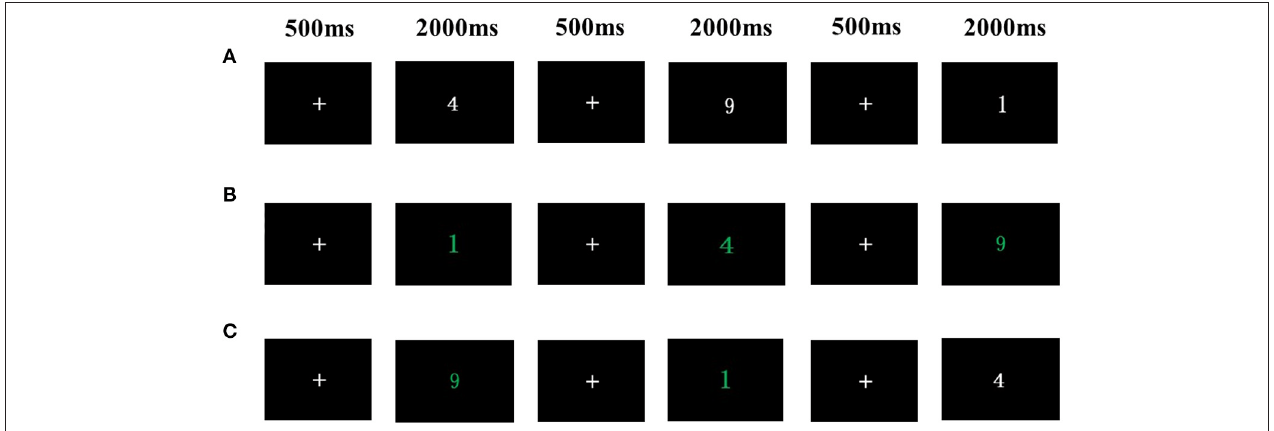
FIGURE 1 | More-odd shifting task. (A) Condition1: Participants determined whether the white digit presented was greater or less than 5. (B) Condition 2: Participants determined whether the green digit presented was odd or even. (C) Condition 3: A white or green digit was presented at random and participants responded